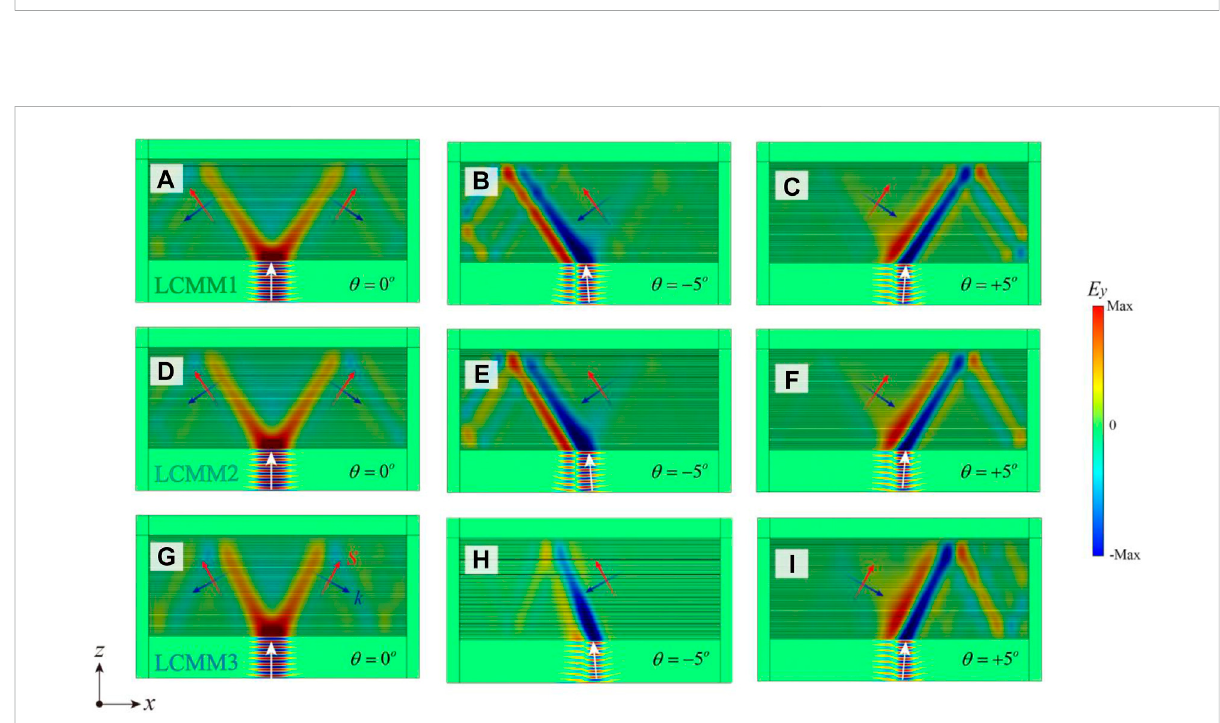
FIGURE 7 Beam splitting and unidirectional refraction of MLCMM based on thestep-likemultilayer structure. (A) Beam splitting when thelightis normally incident on the LCMM1. (B), (C) The directional refraction of LCMM1 when the incident angle is − 5 o and + 5 o , respectively. (D – F) (G – I) Similar to (A – C) , but for the LCMM2 and LCMM3,